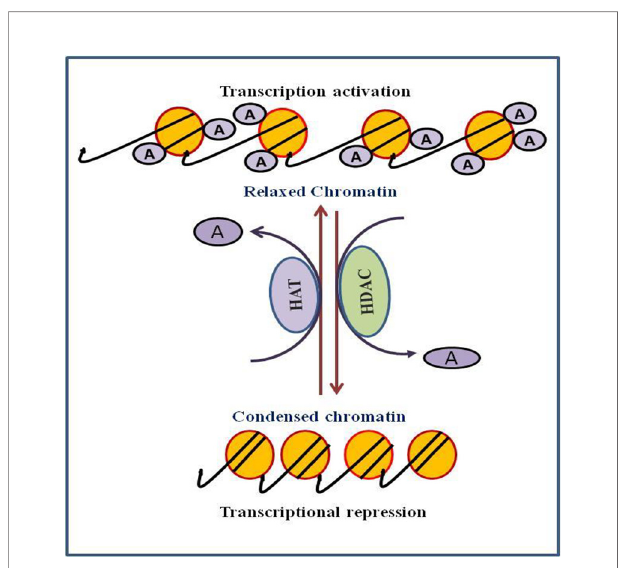
FIGURE 1 | Role of histone acetylation and deacetylation in process of transcription